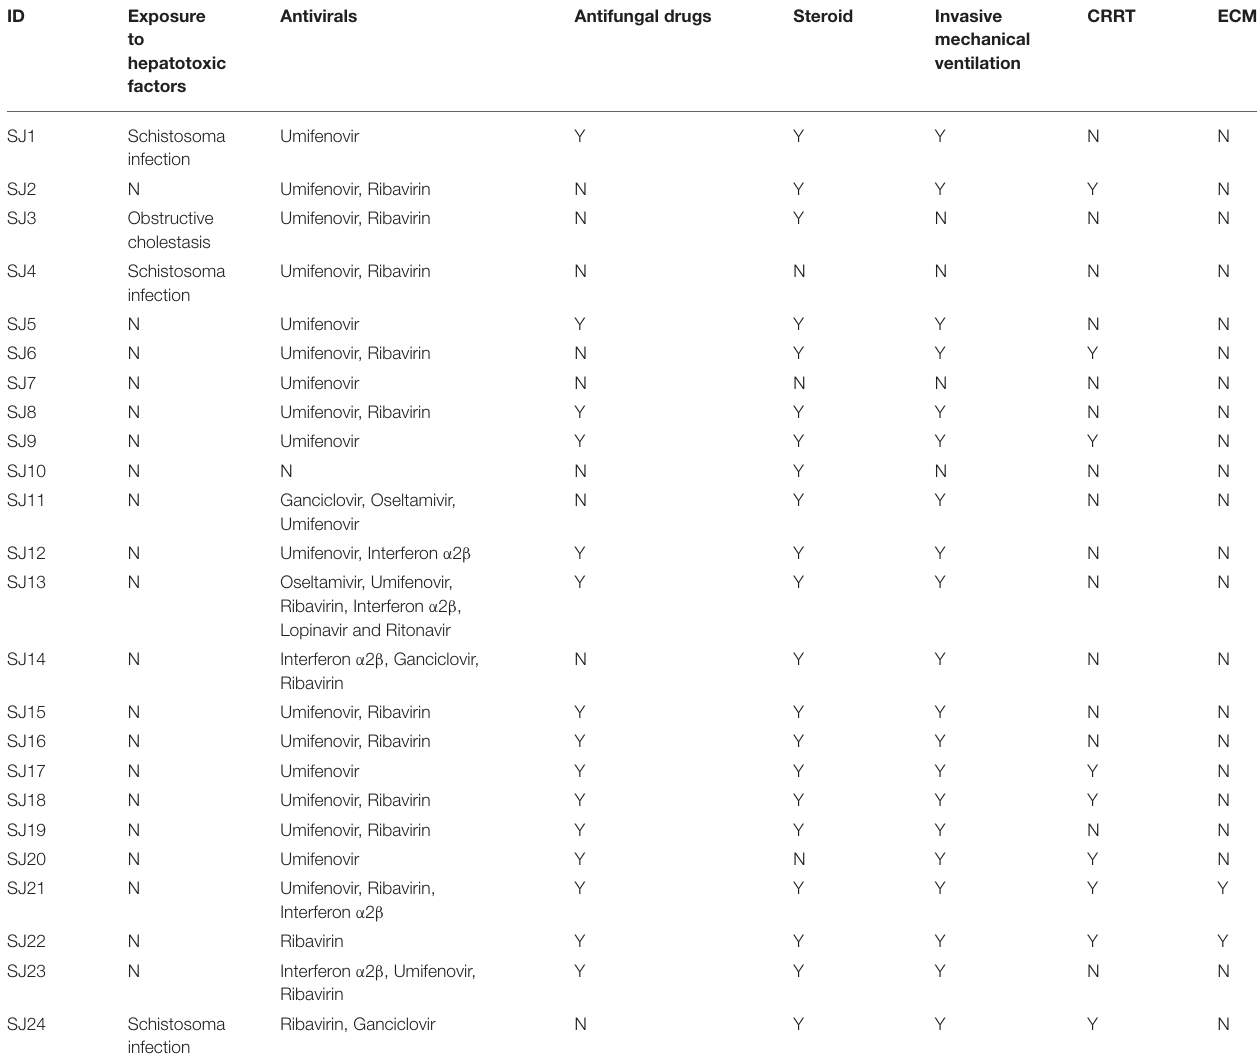
CRRT mechanical ventilation